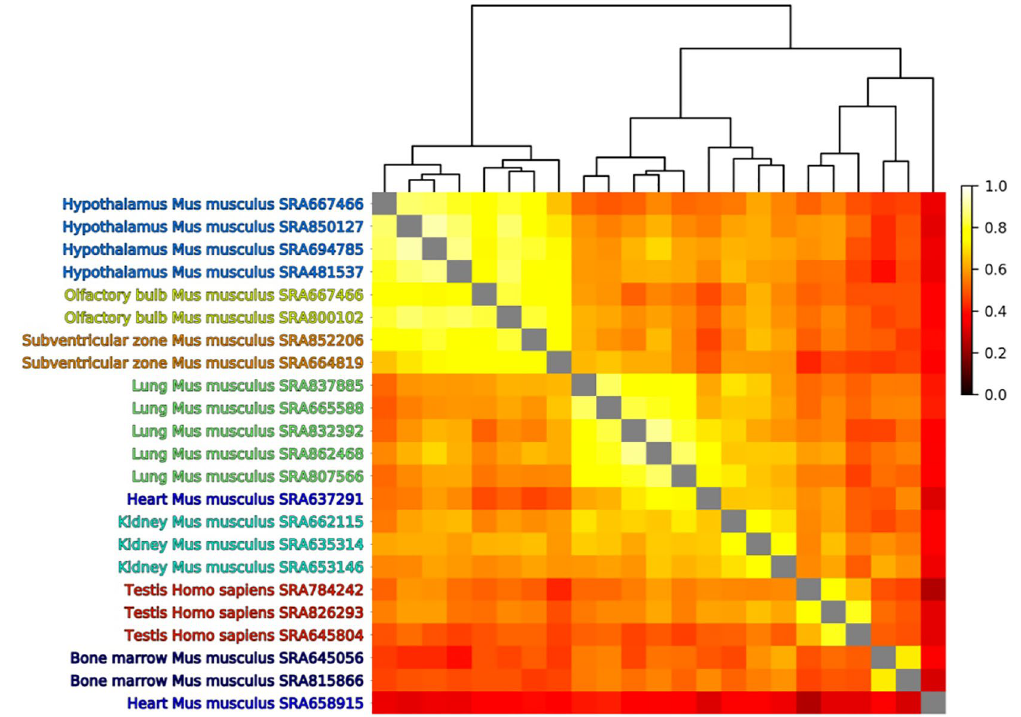
Figure 3. Analysis of endothelial cells from selected studies in PanglaoDB database annotated by DCS. Clustering of Pearson correlation of the largest peak bootstrap frequencies for the combination of measures. Studies from almost all similar tissues group together.